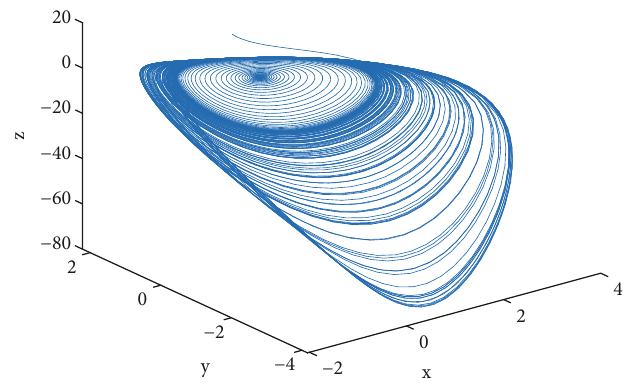
Figure 1: Three-dimensional attractor diagram of system (1): 3D ( 𝑥 − 𝑦 − 𝑧